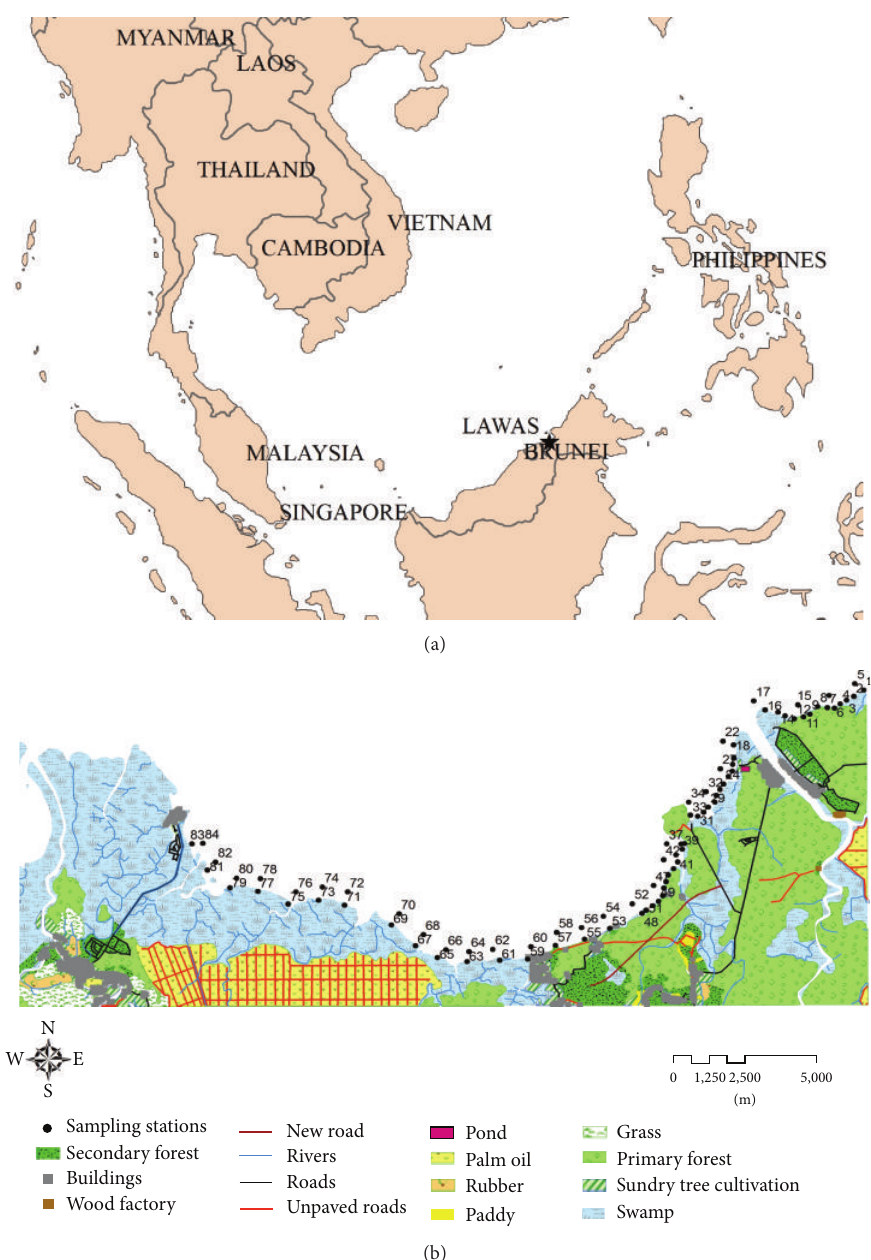
Figure 1: Map representing the location of the (a) study area in Lawas, Sarawak, East Malaysia and (b) the sampling stations established. test. The Friedman test is a nonparametric repeated measures ANOVA. It is useful to test differences between several related groups when assumptions for repeated measures ANOVA are violated and when data is ordinal